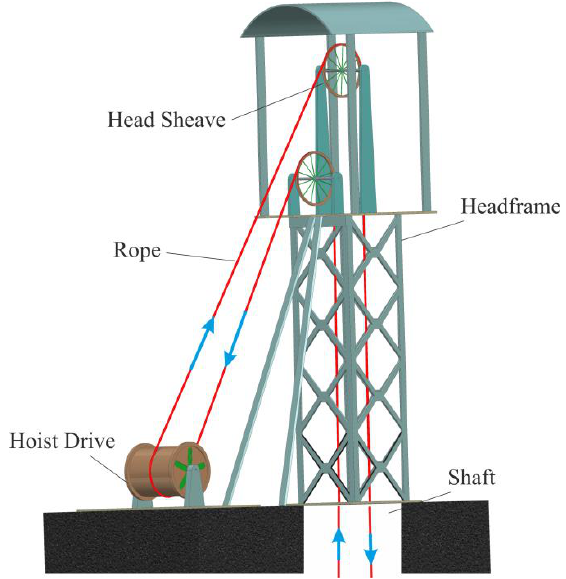
Figure 1. A multi-rope friction hoisting system layout.